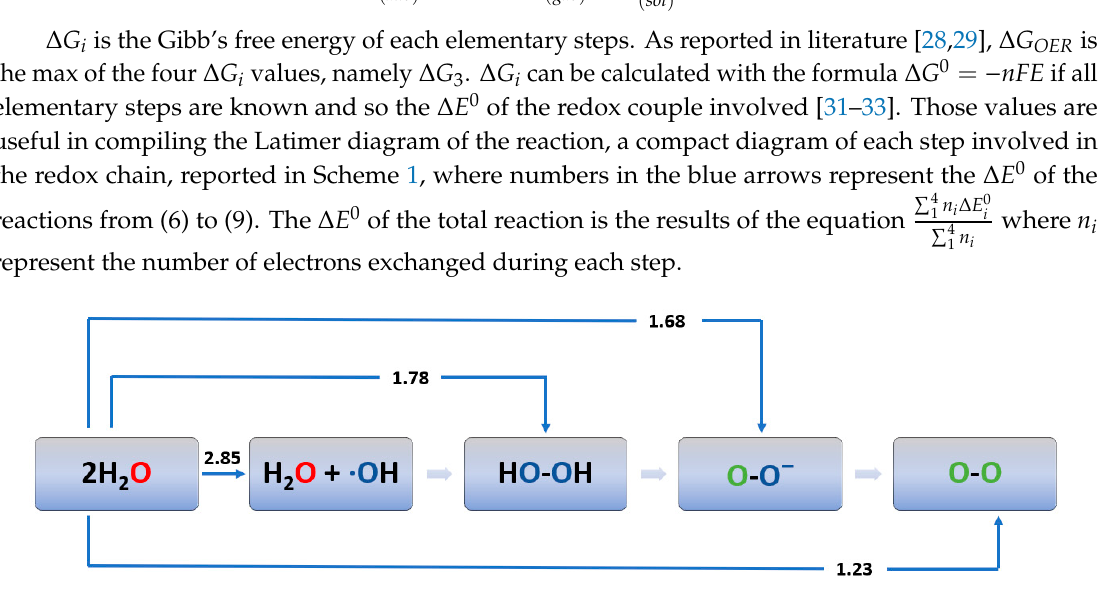
Scheme 1 . Water electrolysis: Latimer reaction